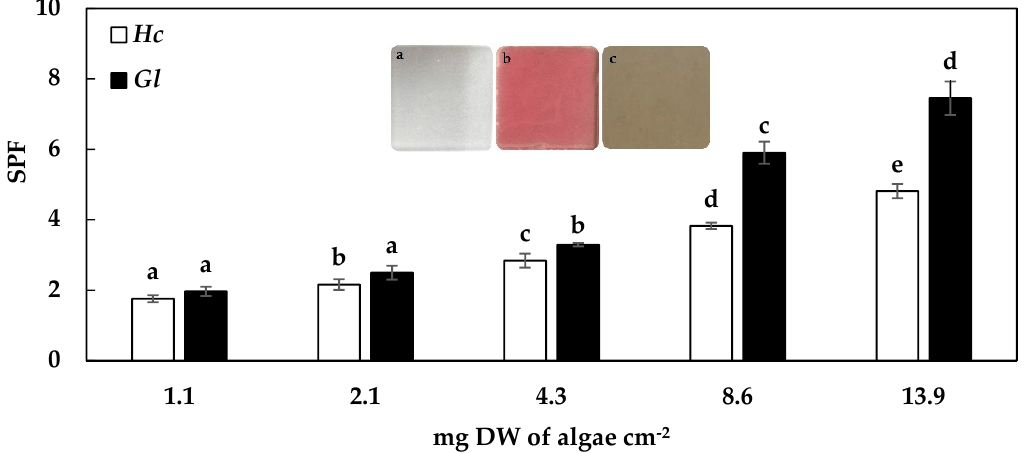
Figure 1. Photoprotection values (SPF, 290–400 nm) for the extracts of Hydropuntia cornea ( Hc ) and Gracilariopsis longissima ( Gl ) at different concentrations. The letters on the histogram bars ( a – e ) correspond to significant differences between the concentration for each species studied in a post-hoc analysis (SNK) for a one-way ANOVA. The three images in the middle correspond to the plate PMMA without extract ( a ), with Hydropuntia cornea ( b ), and with Gracilariopsis longissima ( c ) extracts at 8.6 mg DW cm − 2 .